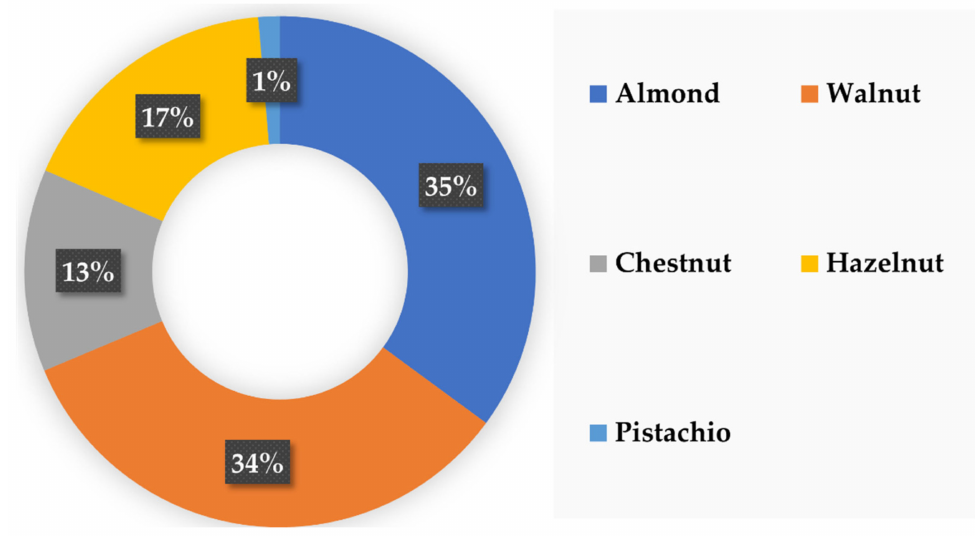
Figure 4. Proportion of nut production in